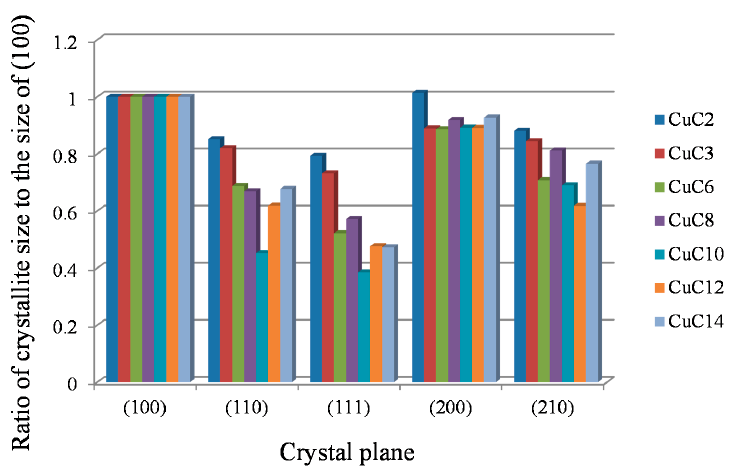
Figure 5. Ratio of size of each crystal plane to the size of the (100) plane.